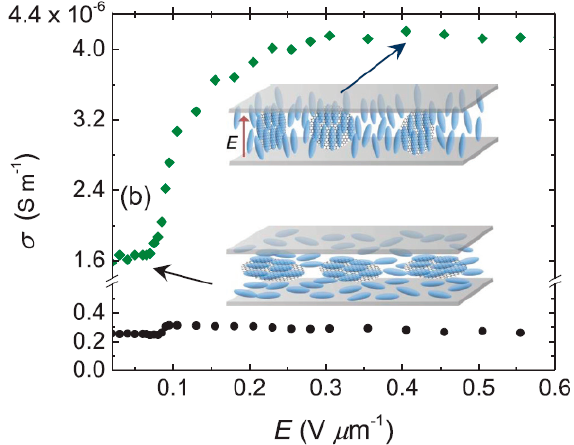
Figure 11. The electrical conductance, σ , as a function of the applied rms (root mean square) field E (f = 1000 Hz) in the nematic phase (T = 50 °C) for the pure LC and LC/graphene (GP) composite (GP concentration 2.29 × 10 4 wt. %.) The reorientation of the graphene flakes with the nematic director is shown in the inset schematics [62].